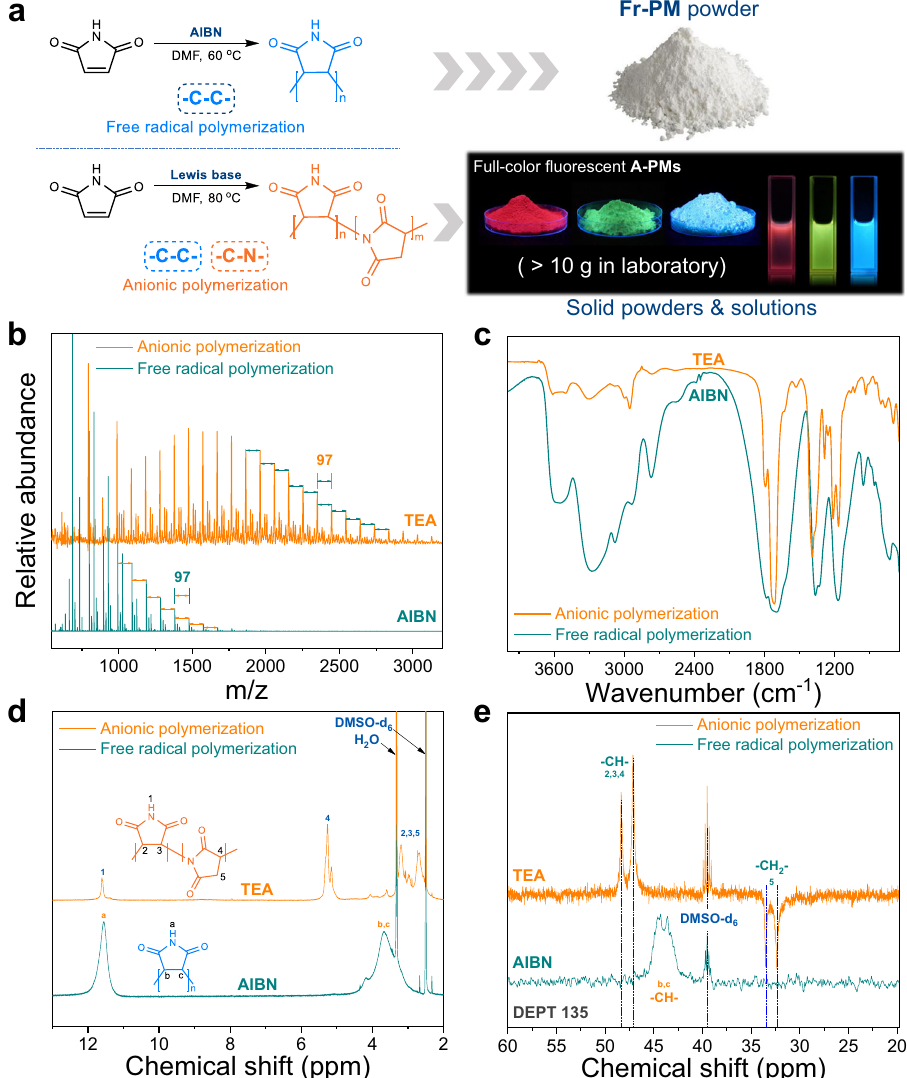
Fig. 1 Synthesis and characterization of fl uorescent polymaleimides (PMs). a Synthetic routes and fl uorescent images of PM powders and solutions in DMF via anionic polymerization (A-PM) and free-radical polymerization (Fr-PM). b – e MS, FTIR, 1 H NMR and 13 C NMR DEPT (Fr-PM was tested at 100 o C) for comparative analysis of the typical A-PM and Fr-PM